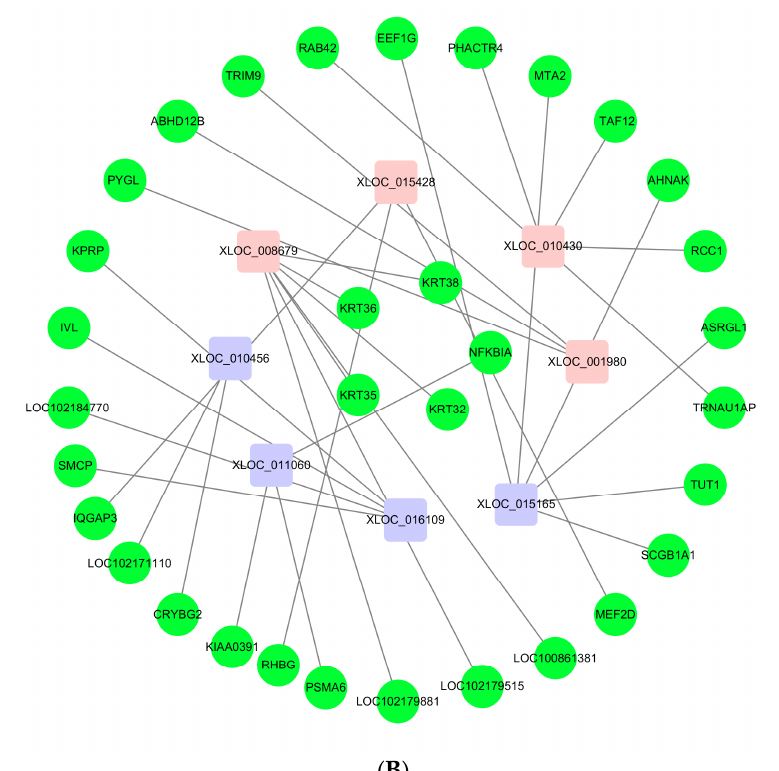
Figure 6. The network of differentially expressed lncRNAs. ( A ) Network of differentially expressed lncRNAs and target genes. Light pink: Up-regulation gene, lilac colour: Down-regulation gene, green: Target gene, light blue: Co-up-regulated and down-regulated target gene. ( B ) Network of qRT-PCR verification for lncRNAs and target genes. Light pink: Up-regulation gene, lilac colour: Down-regulation gene, green: Target gene.